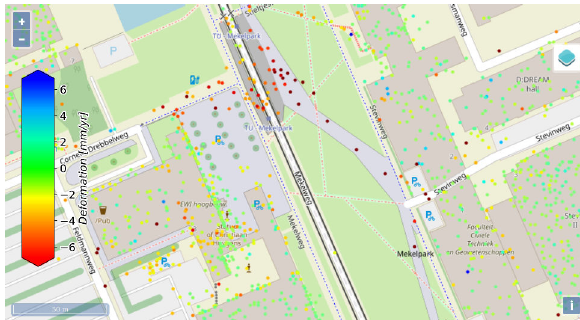
Figure 10. Point locations (mapped in 2D), after matching between the datasets. Compare to figure 2. (Background: